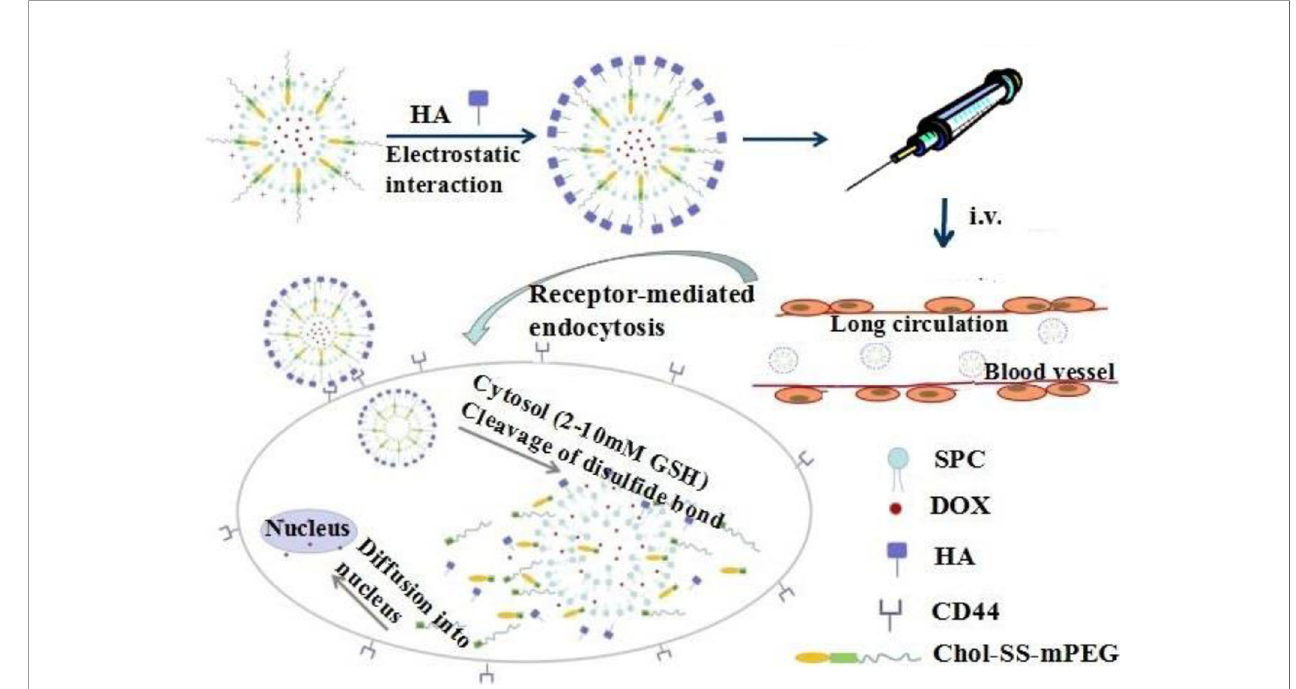
FIGURE 1 | Chol-SS-mPEG/HA-L designed for long circulation in vivo followed by receptor-mediated endocytosis and GSH-triggered cytoplasmic DOX release. Reproduced from (10) with permission from J Control